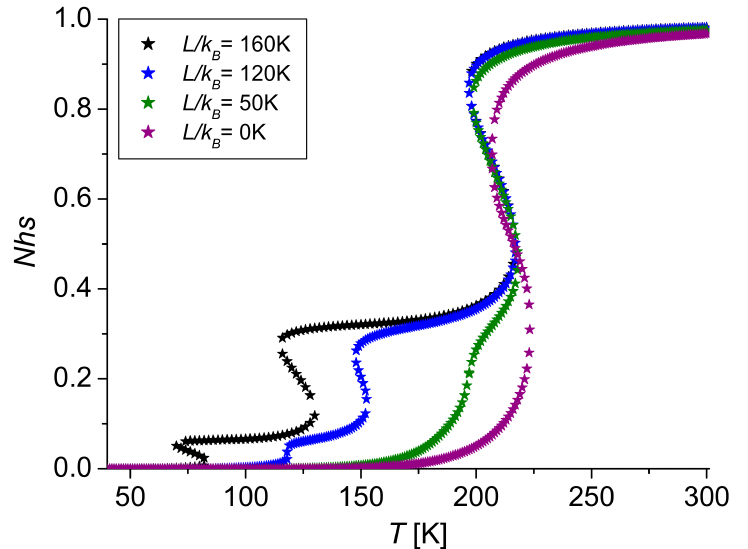
Figure 4. The simulated thermal evolution of the HS fraction Nhs for different values of the L / k B parameter for the H6 system (91 atoms). Black stars: L / k B = 160 K; blue stars: L/k B = 120 K; green stars: L / k B = 50 K; and purple stars: L / k B = 0 K. The computational parameters were: ∆ / k B = 1300 K,